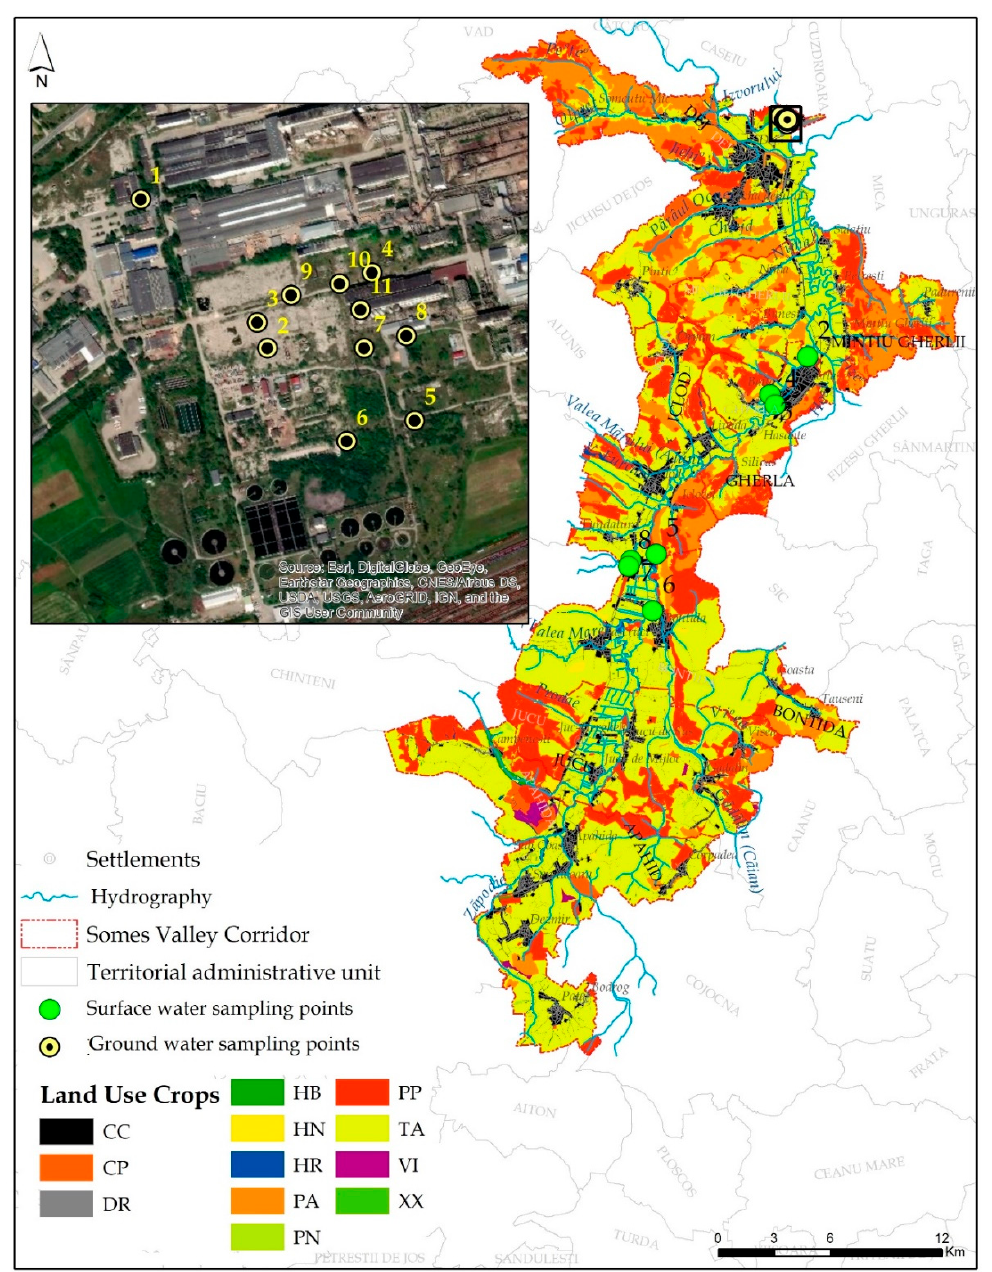
Figure 3. Geographic position of the soil and water sampling sites (where: CC—land occupied by buildings, yards and industrial zones, CP—permanent crops, DR—land occupied by roads and railroads, HB—water surface, HN—unproductive lands with marsh vegetation, HR—lands occupied by running water, PA—lands occupied by forest vegetation, PN—mine tailings, landfills, PP— permanent pastures, TA—arable land, VI—land with vineyards, XX—areas where no photo interpretation was performed).